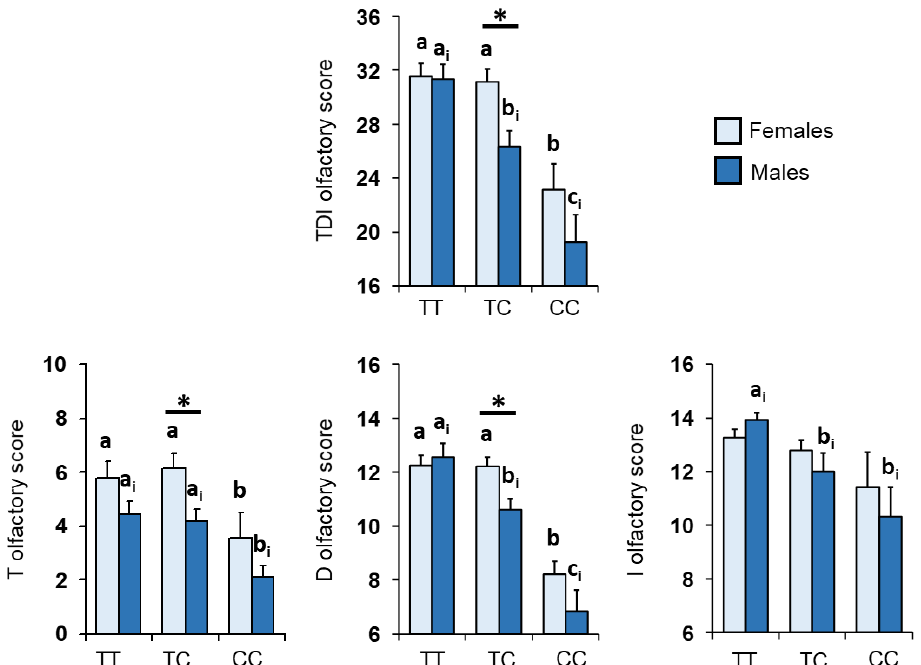
Figure 2. Mean ( ± SEM) values of the threshold (T), discrimination (D) and identification (I) olfactory scores and their summed TDI olfactory scores obtained by females ( n = 59: 32 TT, 22 TC, 5 CC) and males ( n = 43: 13 TT, 18 TC, 12 CC) according to the genotypes of the Kv1.3 locus. Different letters indicate a significant difference: a,b for females (TDI: p < 0.005; T: p < 0.05; D: p < 0.0005; Fisher’s LSD test), a i –c i for males (TDI and D: p < 0.005; T and I: p < 0.05; Fisher’s LSD test). (*) indicates significant differences between females and males with the same genotype ( p < 0.05; Fisher’s LSD